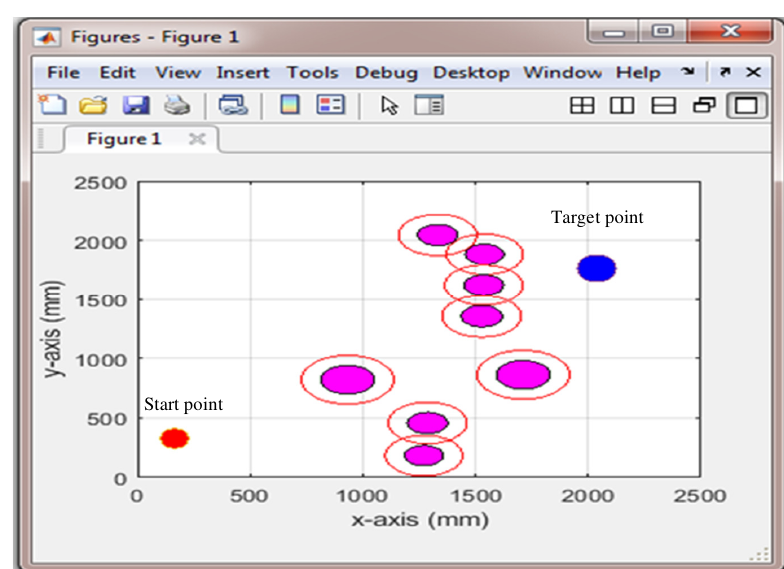
Fig. 6. The Environment of Case 2. The simulation result of the optimum route for the second case based on the proposed algorithm is shown in Figure 7. While figure 8. plotted the relation of the length of the optimal path (better fitness) and the number of iterations for estimation